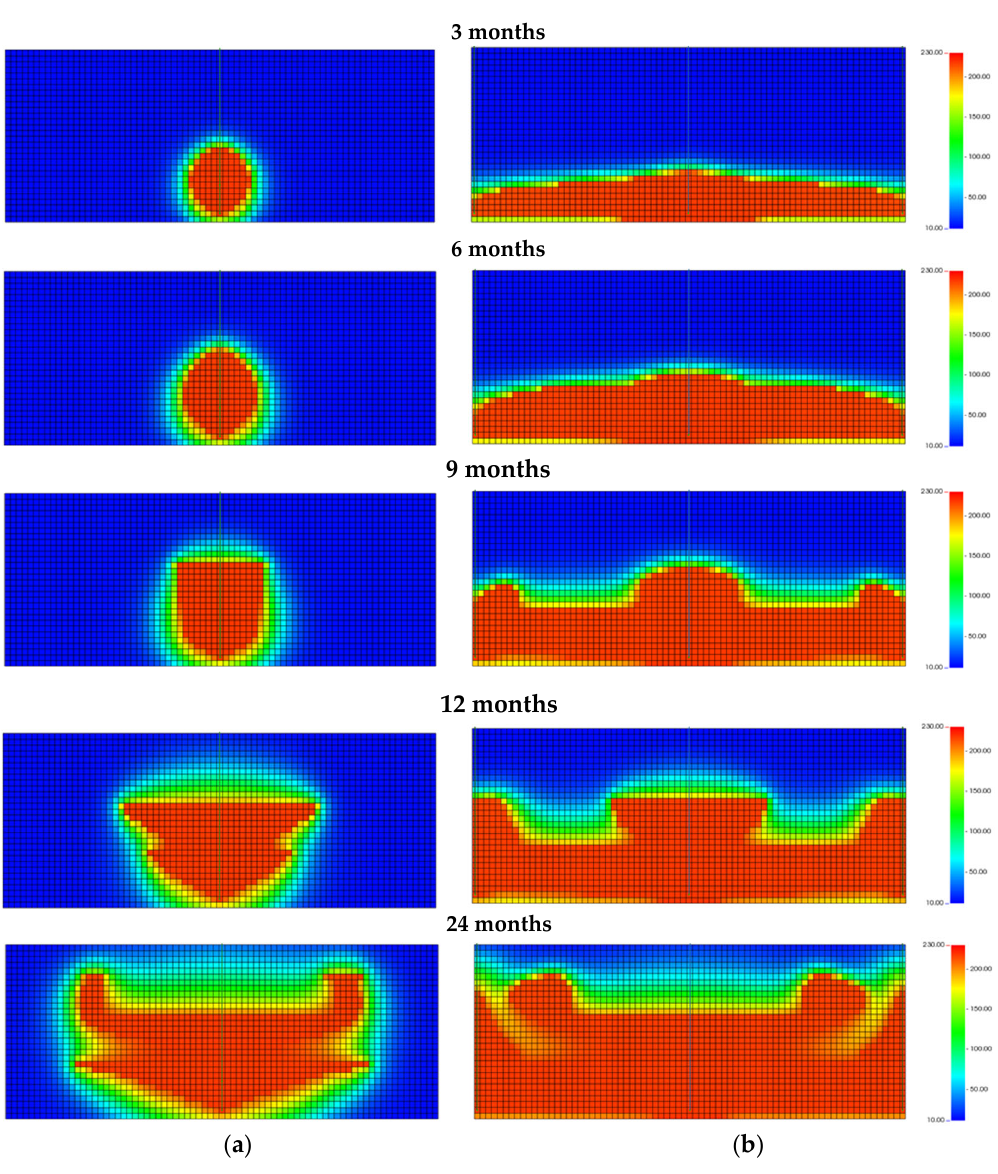
Figure 4. Comparison of steam chamber development between ( a ) SAGD processes and ( b ) bottom- up assisted pressure drive at different times of operation.